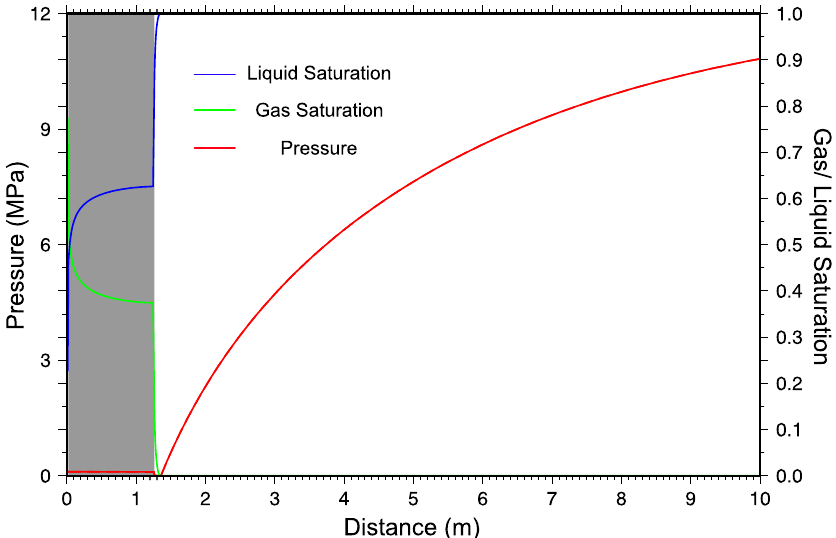
Figure 6. Pressure and liquid/gas saturation initial conditions for each 1D simulation. The shaded grey region represents the extent of the DRZ and the double-porosity portion of the mesh, which extends 1.25 m from the